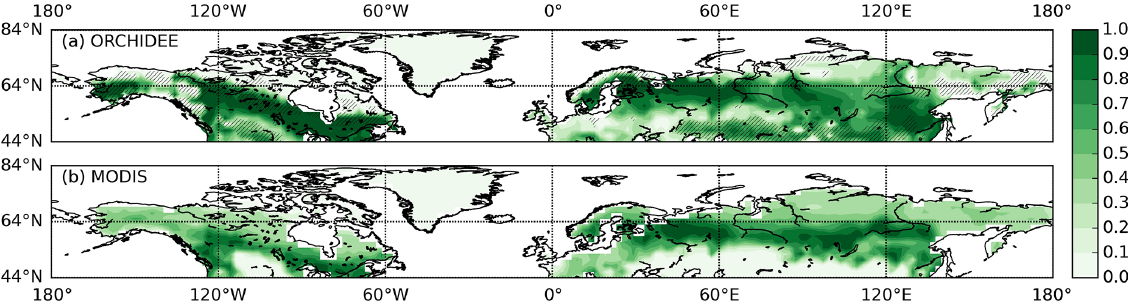
Figure 2. Simulated ( a ) and MODIS-derived ( b ) foliage projective tree cover in fraction of ground area. The MODIS tree cover data are derived by cross-walking MOD12Q1 version 5 land-cover types to plant functional types (PFTs) in ORCHIDEE using the methods developed by Poulter et al. (2011). Hatched areas show where the two data sets differ by >30% of ground area.